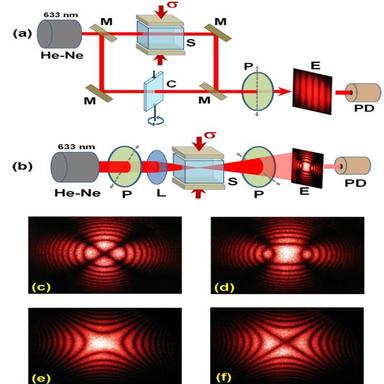
Experimental setups for piezooptic measurements combining Mach-Zehnder (a) and conoscopic (b) interferometry. M - mirrors, C - optical pathlength compensator, P – polarizers, L – lense, E – screens, PD – photodetectors. Sample S is subjected to uniaxial compression . Sections (c) and (d) demonstrate conoscopic images captured at 2 =0 and 2 =230 kgf/cm2, respectively, for transverse piezooptic coupling geometry (k=3, m =2). Sections (e) and (f) show conoscopic images captured at 2 =0 and 2 =180 kgf/cm2, resp